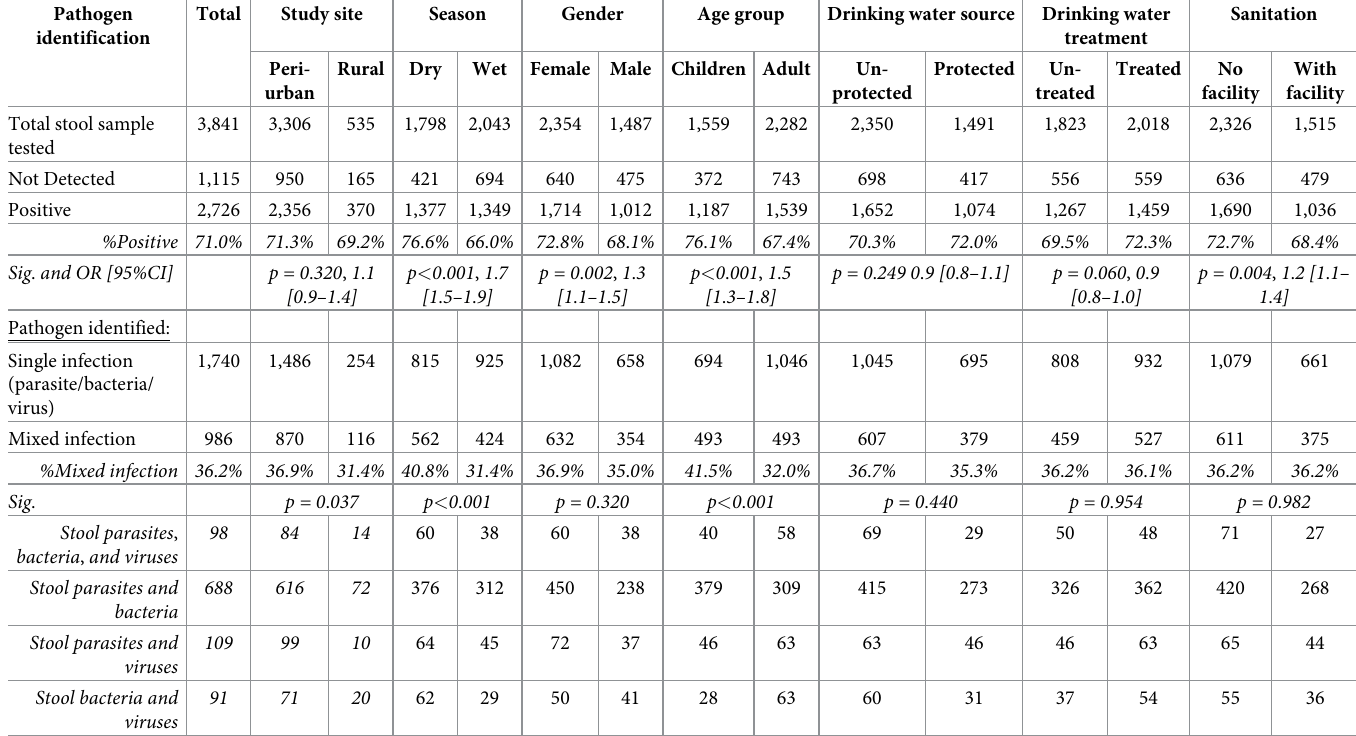
Table 4. Summary of stool specimen sample characteristics. Pathogen